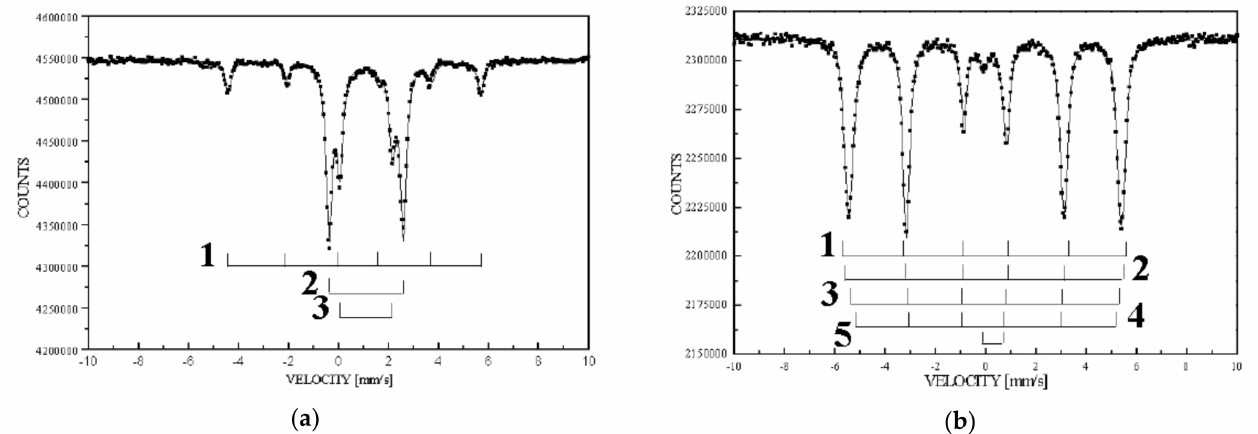
Figure 14. Room temperature Mössbauer spectra of equilibrated ordinary chondrite El Hammami H5: mineral fraction ( a ) and magnetic fraction ( b ). Spectral components are explained in the text. Adapted from Reference